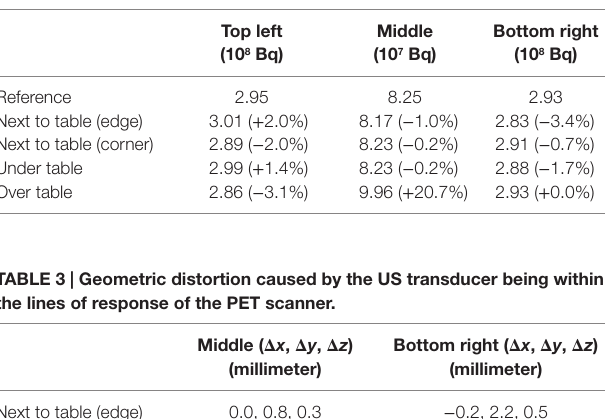
TaBle 2 | Measured activities of the three point sources (top left, middle, bottom right) for the four different Us transducer positions compared to the reference without transducer.